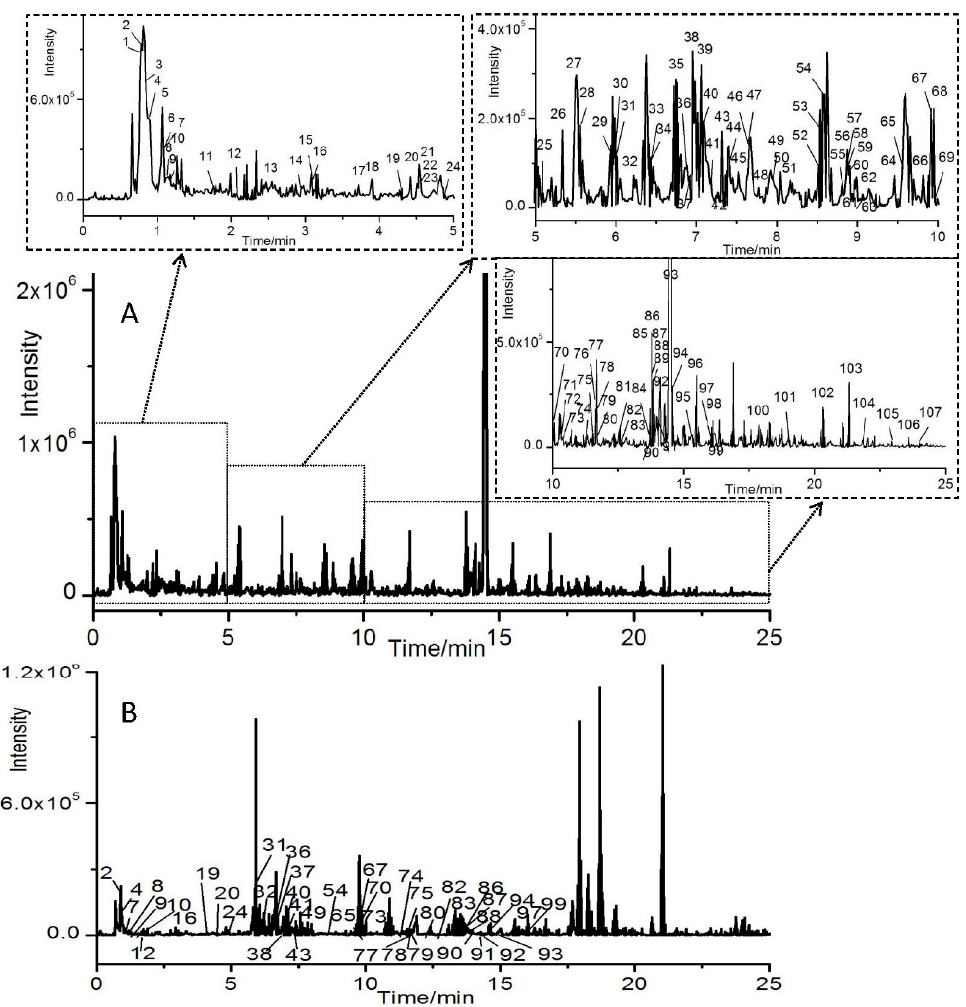
Figure 1. Total ion chromatography of HGKYC extract ( A ) and rat serum after oral administration